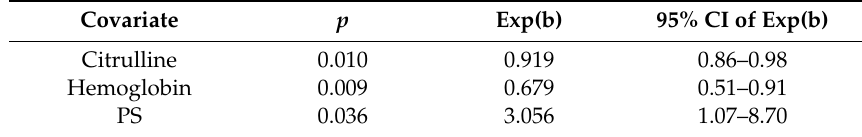
Table 3. Multivariate Cox regression of significant prognostic factors.